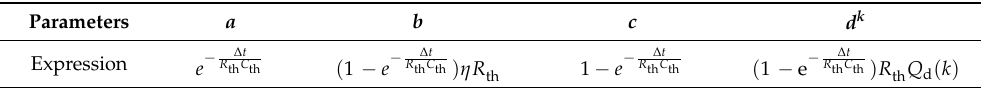
Table 1. Mathematical expression of the thermal dynamic model